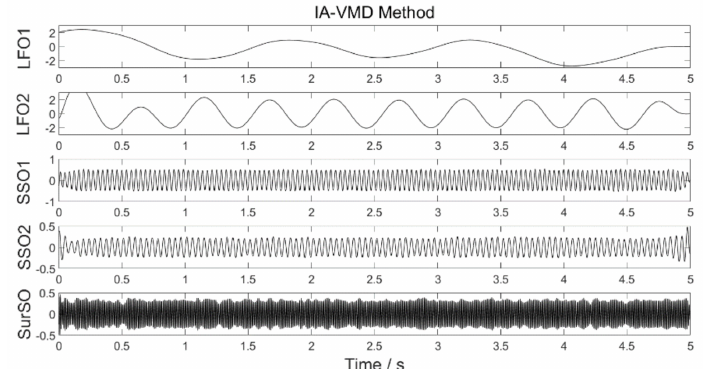
Figure 4. All modes of the signal with noise after IA-VMD.